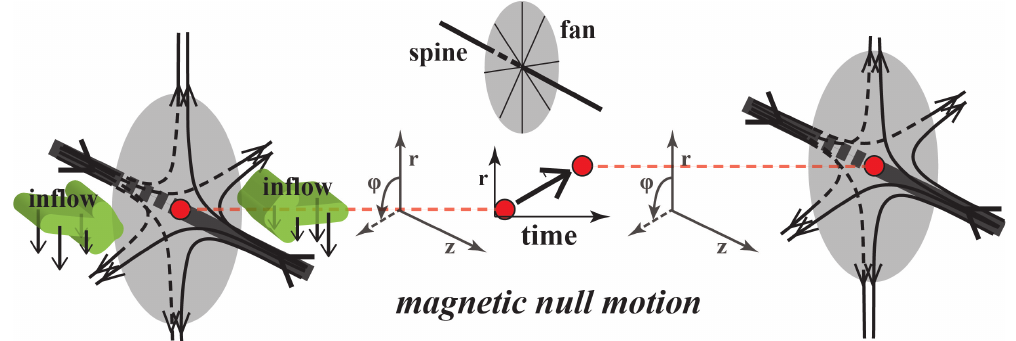
Fig. 6. Schematic of the spine-fan magnetic null centered between the two spheromaks. As the symmetry of the null is broken and magnetic reconnection commences, in-plane plasma flows carry into the null the component of magnetic field perpendicular to the reconnection plane. These field components, originally the toroidal fields of the spheromaks, are co-aligned and combine with corresponding components of the fan magnetic field around the null. As a result, the magnetic null moves along a radial cord in the plane of the fan and normal to the reconnection